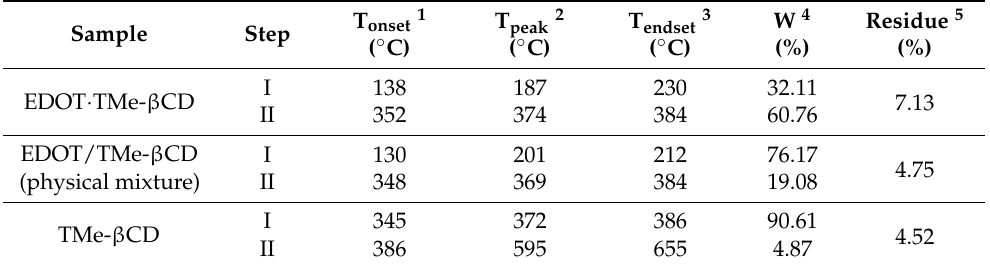
Table 2. Thermogravimetric data of EDOT ∙ TMe- β CD, physical mixture, and TMe- β CD.